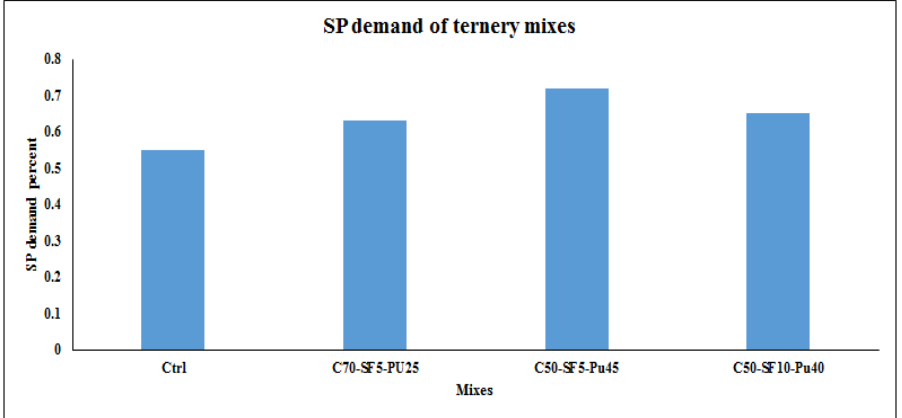
Figure 11. SP consumption of ternary mixes for the fixed 65 cm slump.